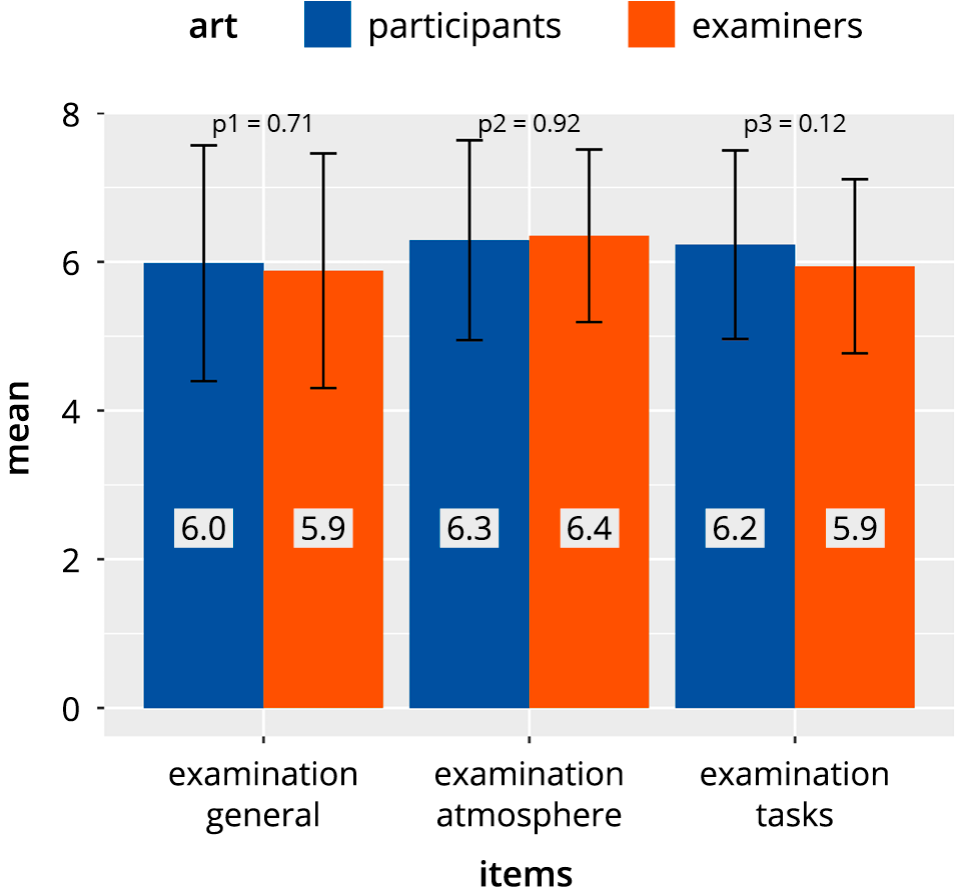
Figure 2. Comparison of the higher-level common item categories in direct observation of procedural skills (DOPS) tests in participants and examiners.